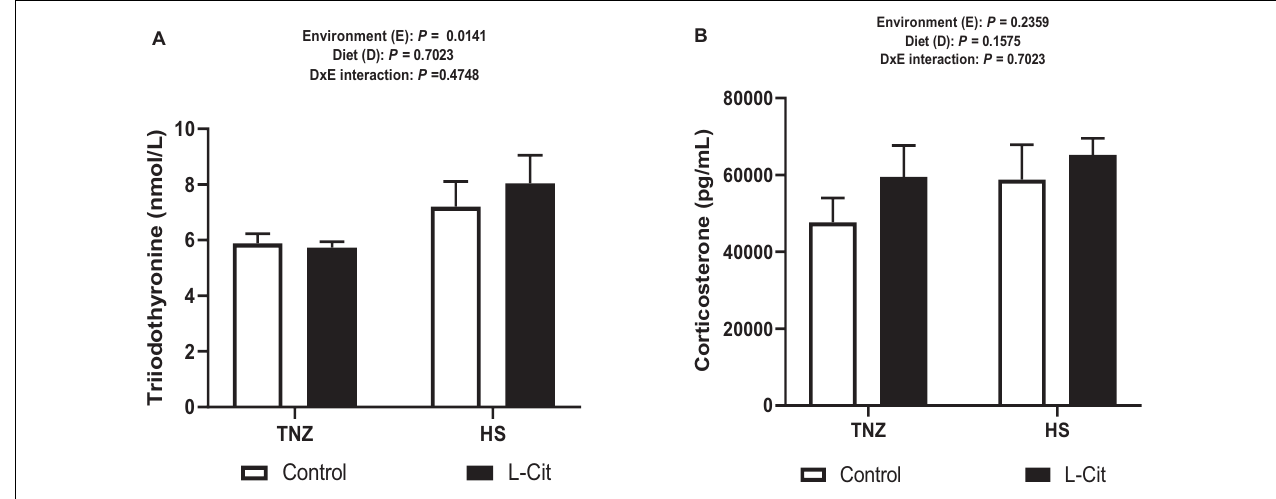
FIGURE 2 | Effect of heat stress and L -citrulline supplementation on circulating hormone levels. (A) Triiodothyronine (T 3 ). (B) Corticosterone levels. Data are presented as mean ± SEM ( n = 8). TNZ, thermoneutral; HS, heat